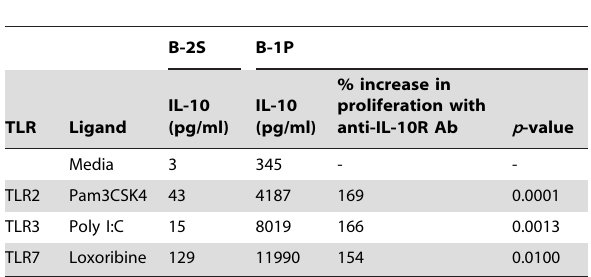
Table 1. TLR induced IL-10 production by B-2S and B-1P cells and its inhibitory effects on B-1P